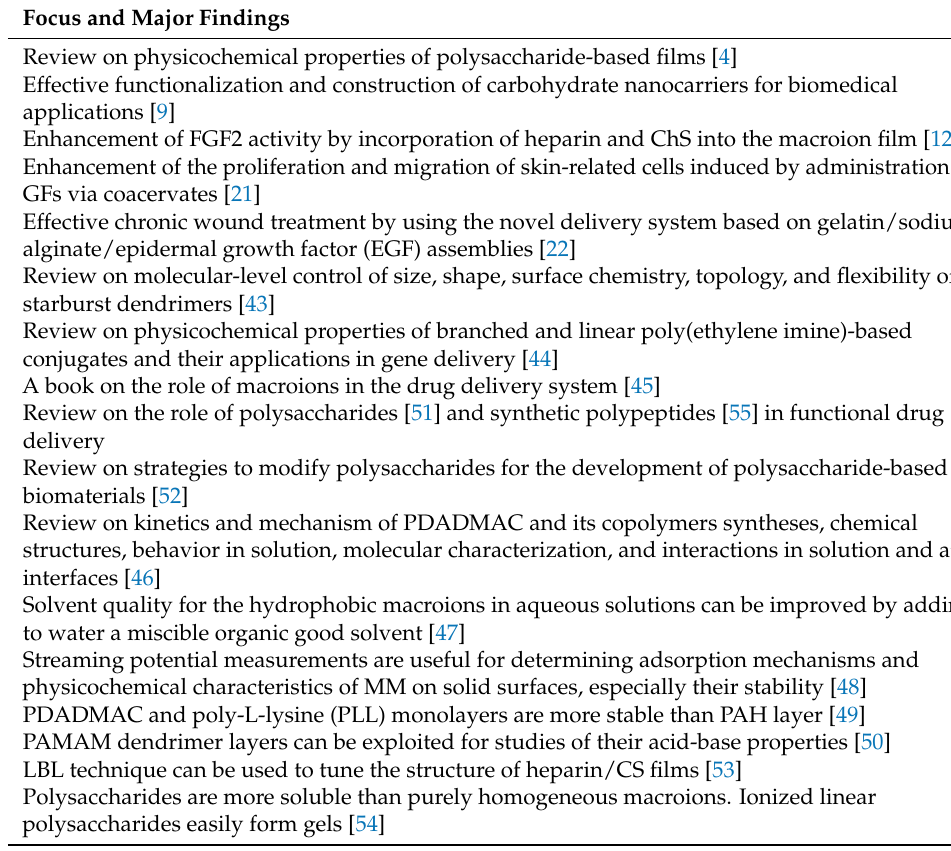
Table 2. Focus and major